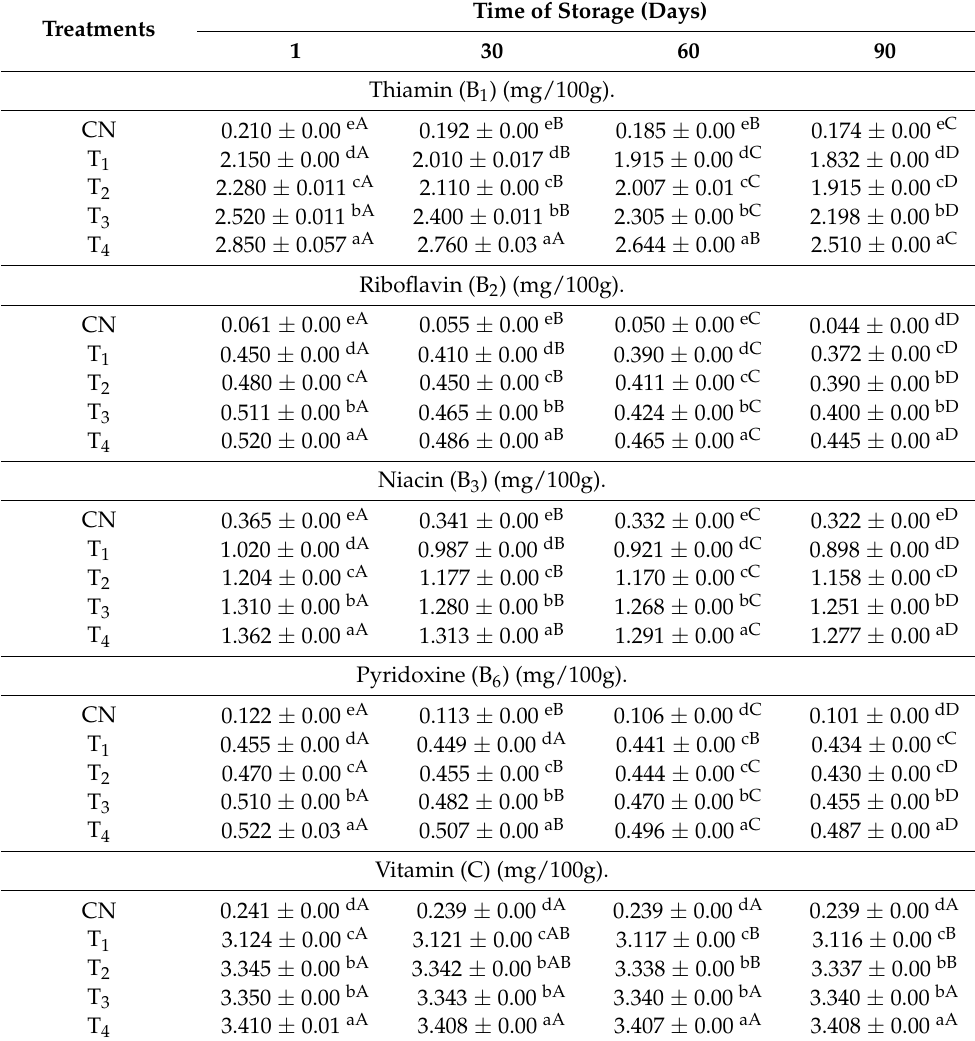
Table 5. Changes in vitamin contents in frozen yoghurt affected by adding substantial ratios of JATP during cold